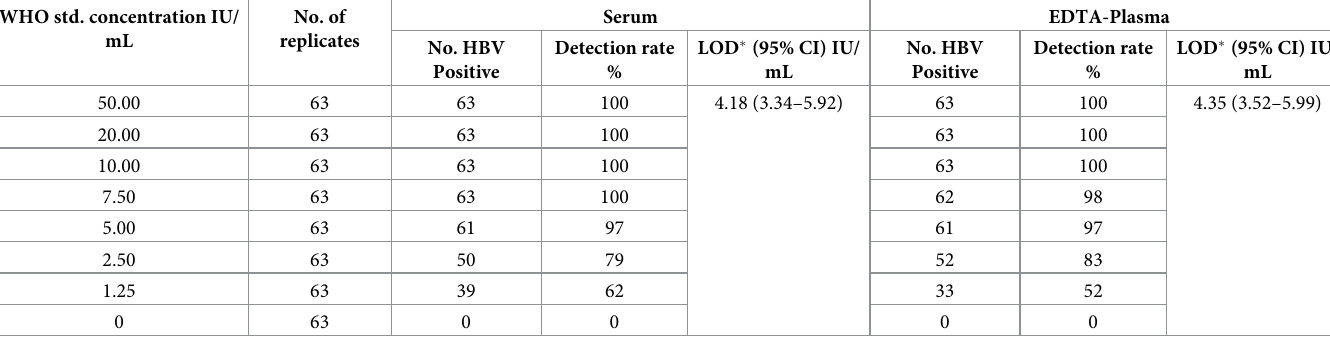
Table 1. Limit of detection in the serum and EDTA-plasma using the 4 th WHO international standard for HBV. WHO std. concentration IU/ No. of mL